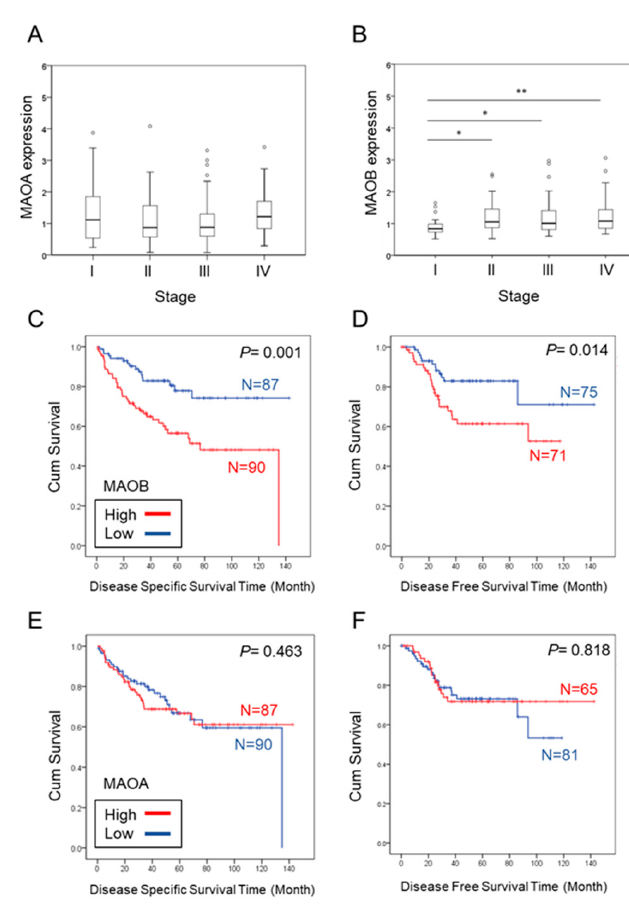
Figure 2. Correlation of the monoamine oxidase (MAO) A (MAOA) and MAOB expression levels with prognosis in a colorectal cancer database (GSE17536). ( A , B ) MAOA ( A ) and MAOB ( B ) gene expression levels in CRC tissues from the Gene Expression Omnibus (GEO; GSE17536) were compared according to clinical stages. The patient numbers of stage I, II, III, and IV were respectively 24, 57, 57, and 39. Statistical significance was analyzed by a t -test. * p < 0.05; ** p < 0.01. ( C , D ) Kaplan–Meier plots of the disease-specific survival (DSS) curves ( C ) and disease-free survival (DFS) curves ( D ) for MAOB (probe ID: 204041_at) expression. ( E , F ) Kaplan–Meier plots of DSS curves ( E ) and DFS curves ( F ) for MAOA (probe ID: 204388_s_at) expression. The average survival periods of DSS and DFS were 48.1 and 37.5 months, respectively. The red line indicates high expression of MAOs, and the blue line indicates low expression.